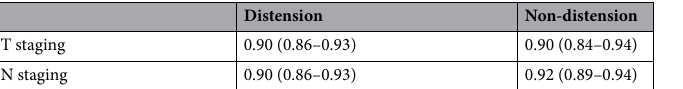
Table 2. Inter-rater reliability. Intraclass correlation coefficients (ICC) presented with 95% confidence intervals in parenthesis is based on mean-rating, absolute-agreement, 2-way random effects model. For TN staging ICC based on 4 independent readers and 1 tumor board reading.